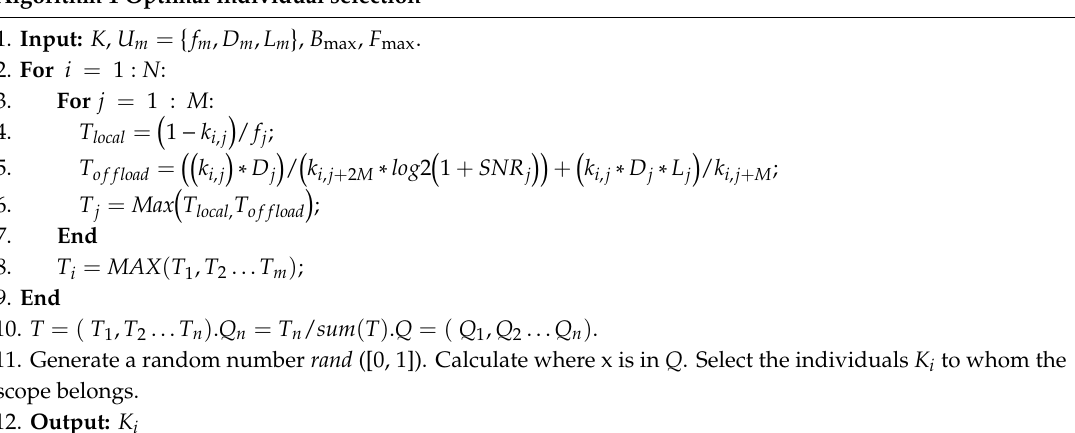
Algorithm 1 Optimal individual selection